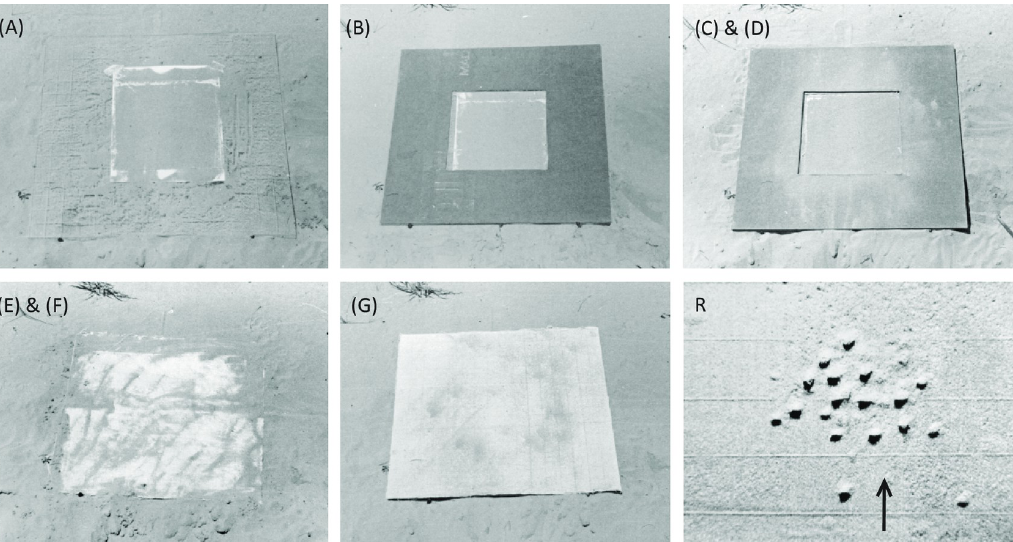
Fig 2. Investigating local burrow location cues I. Twelve returning wasps were confronted with seven different covers placed over their burrows. A—G refer to the experimental conditions (see Methods for details and Fig 6 for results). Condition (A) : Three layers consisting of a plexiglass board, paper, and cloth to exclude olfactory, auditory and tactile cues. Overall apparatus height is 0.3 cm. Condition (B) : Same as A, but with an additional frame excluding subtle changes in the sand-surface relief. Overall apparatus height is 0.6 cm. Conditions (C) & (D) : As in B, but without plexiglass board. Overall height of each is 0.3 cm. Condition (E) : With single cloth layer, and Condition (F) : Flexible plastic sheet under cloth. Apparatus height for both is 0 cm. Condition (G) : Cloth stretched over frame. Height is 0.3 cm. R Shows the distinct traces left by repeated digging attempts of a returning wasp, using only distant cues, searching for her hidden burrow entrance (grid shows 3.5 cm 2